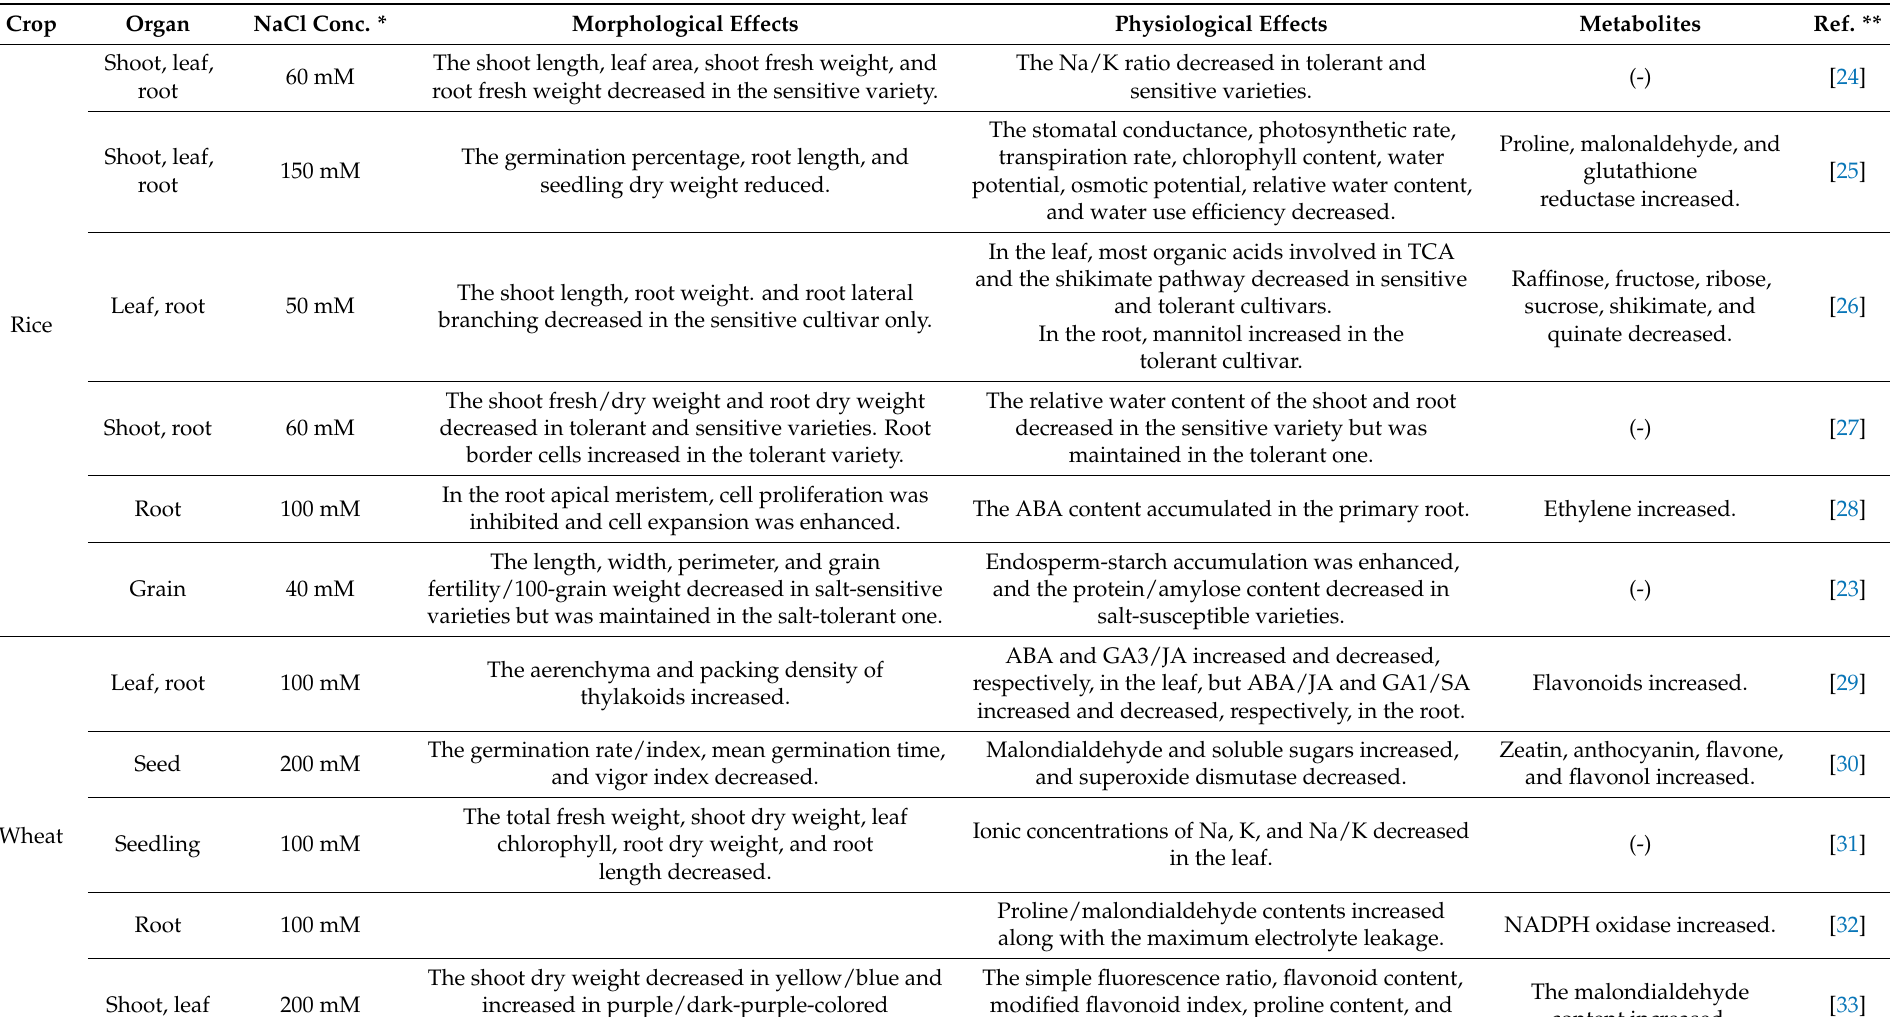
Table 1. Morphological and physiological impacts and effects of salt stress on various crops studied during